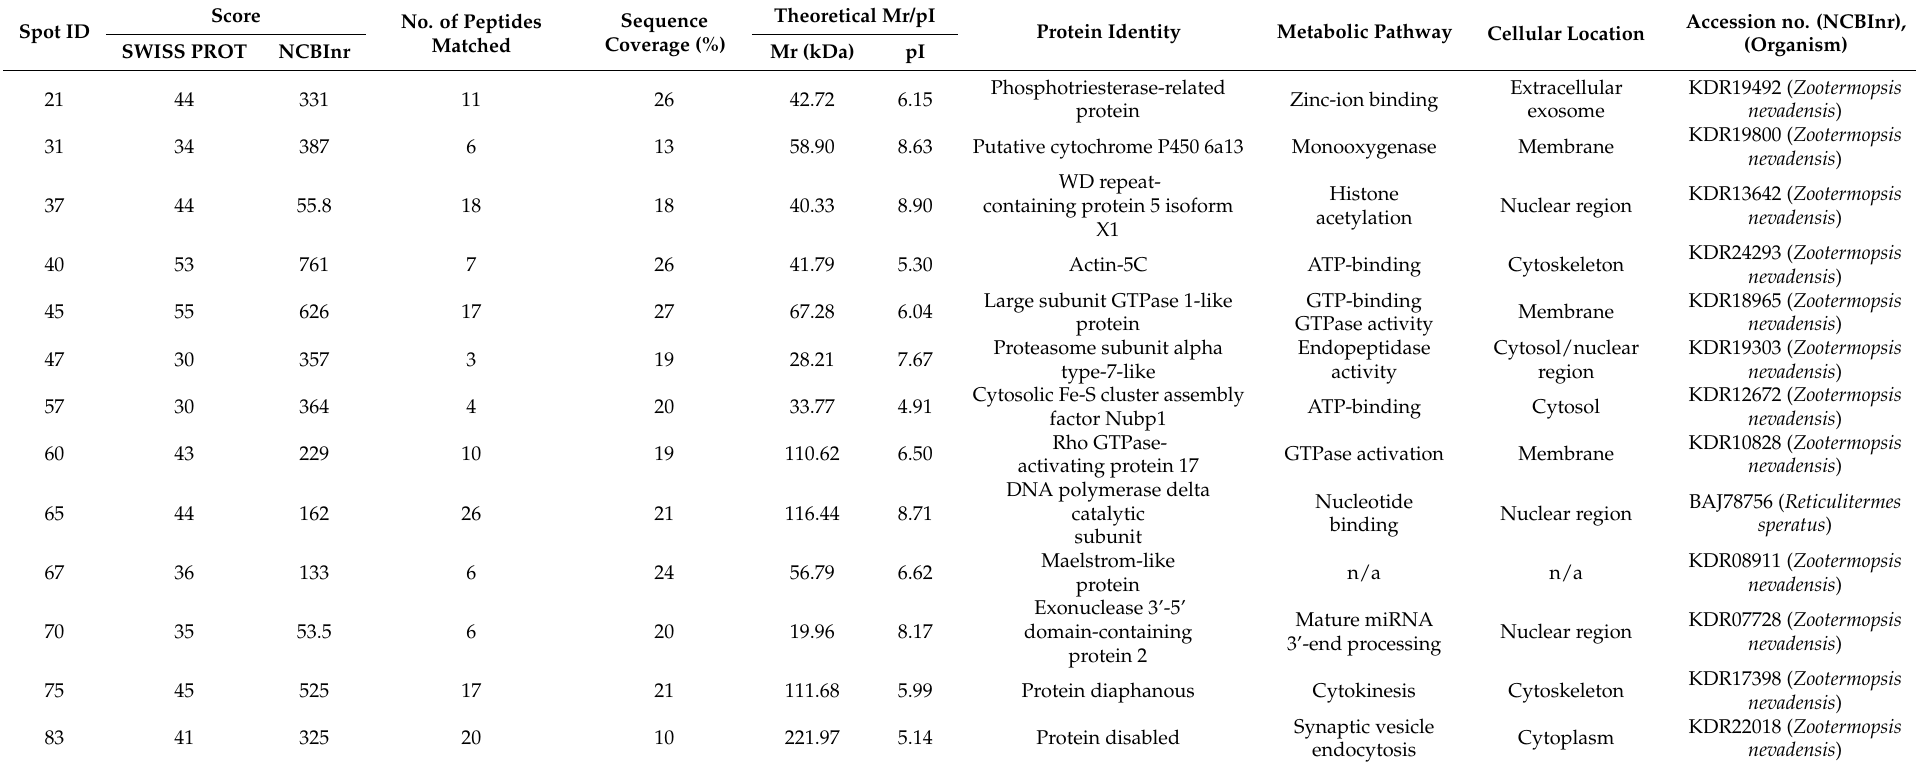
Table 1. MALDI-TOF mass fingerprinting data of the 13 differentially expressed proteins isolated from Metarhizium anisopliae -infected Coptotermes curvignathus . Proteome changes in the infected termite were compared in a time-lined post-inoculation (PI) experiment to control proteins, extracted from 2D electrophoresis gels prior to